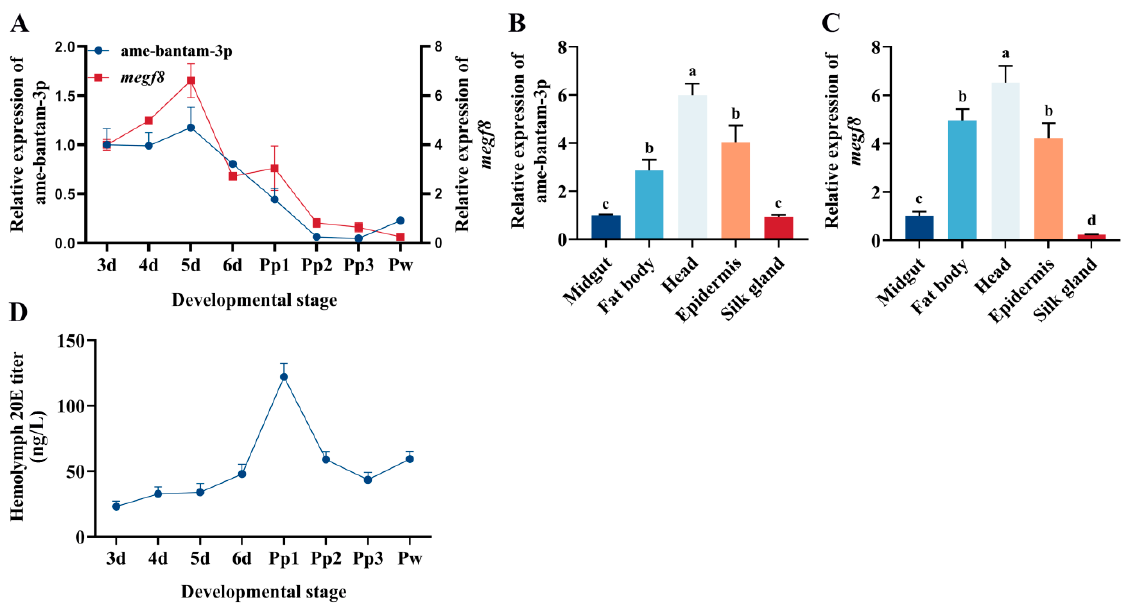
Figure 7. ( A ) The expression levels of ame-bantam-3p and megf8 in the larval–pupal developmental stages. The expression levels of ame-bantam-3p ( B ) and megf8 ( C ) in isolated tissues. Vertical bars represent the mean ± SEM (n = 5) and letters represent significant differences ( p < 0.05). Relative expression levels were denoted as fold-change over that of the internal controls U6 and β -actin , respectively. Each point and histogram bar represents the relative expression, the error bars indicate SEM. ( D ) Hemolymph 20-hydroxyecdysone (20E) titers in larval–pupal developmental stages of the honeybee. Each point indicates the mean ecdysone concentration ± SEM.